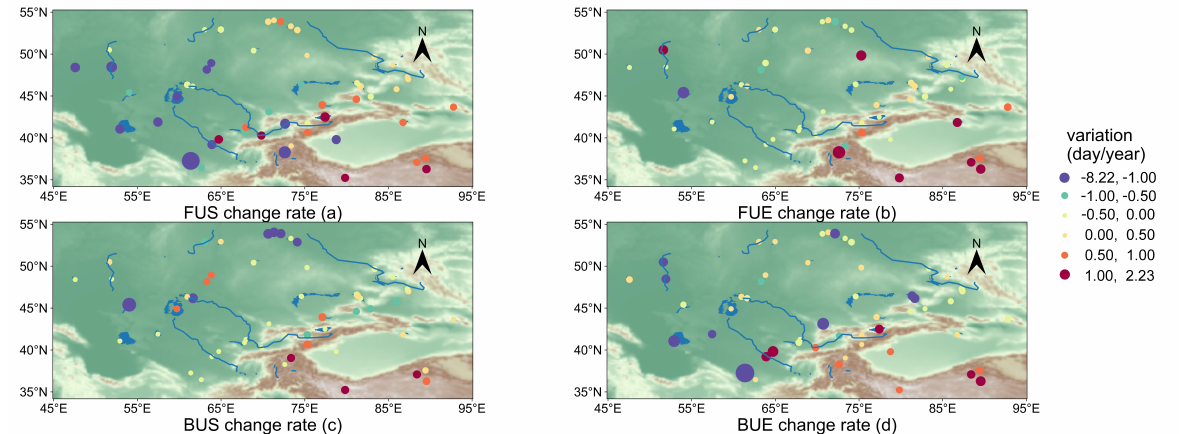
Figure 4. Trends of lake ice phenology variables, the sizes of the circle represent the absolute value in the change rate. The red color indicates a positive change rate and the blue indicates a negative change rate.